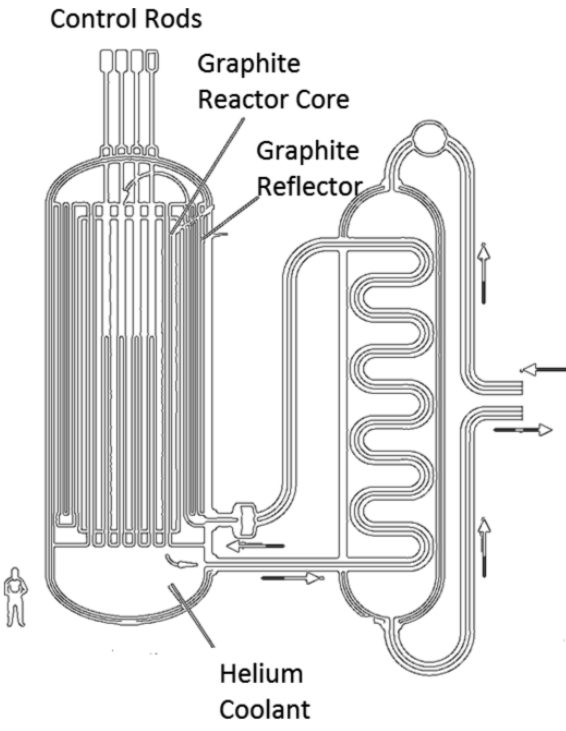
Fig. 8. – Schematic representation of a Very-High-Temperature